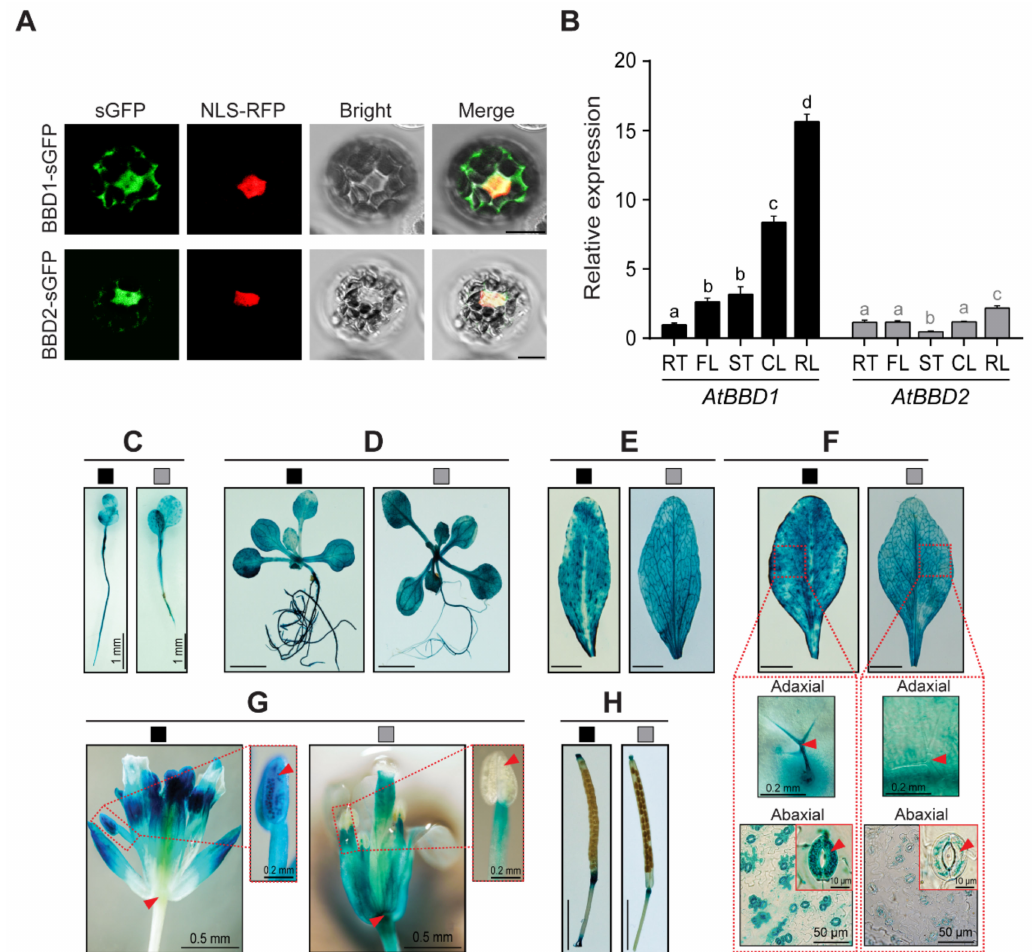
Figure 1. Subcellular localization and tissue-specific expression of AtBBD1 and AtBBD2. ( A ) Subcellular localization of BBD1 and BBD2. Pro 35S :AtBBD1-sGFP or Pro 35S :AtBBD2-sGFP along with Pro 35S :NLS-RFP were transformed into protoplasts isolated from two-week-old Arabidopsis seedlings using a PEG-mediated transformation method. Images of the transformed protoplasts were captured by a confocal laser scanning microscope (LSM 510 META, Zeiss) 20 h after transformation. Scale bar = 10 µ M. ( B ) Spatial expression of AtBBD1 and AtBBD2 determined by qRT-PCR. The relative gene expression was calculated and normalized to the reference gene PP2AA3. The normalized mRNA level in root of AtBBD1 was set to 1. Total RNAs were obtained from the rosette leaves (RL), cauline leaves (CL), stem (ST), flower (FL), and root (RT). Data represent the mean ± standard error values of three independent experiments. One-way ANOVA with post-hoc Tukey test was used for the statistical comparison of all tissues. Different letters indicate significant differences among tissues for each gene ( p < 0.05). ( C – H ) Promoter activities of AtBBD1 and AtBBD2 genes across developmental stages were demonstrated by histochemical GUS analysis of transgenic ProBBD1:GUS and ProBBD2:GUS lines. In each panel, black and gray squares represent AtBBD1 and AtBBD2 , respectively. Red arrow indicates the differential GUS staining between AtBBD1 and AtBBD2. Bar = 10 mm unless written in the figure. ( C ) Five-day-old seedling. ( D ) Two-week-old plants. ( E ) Cauline leaves from three-week-old plants. ( F ) Rosette leaves from three-week-old plants. ( G ) Solitary flower. ( H ) Siliques from five-week-old